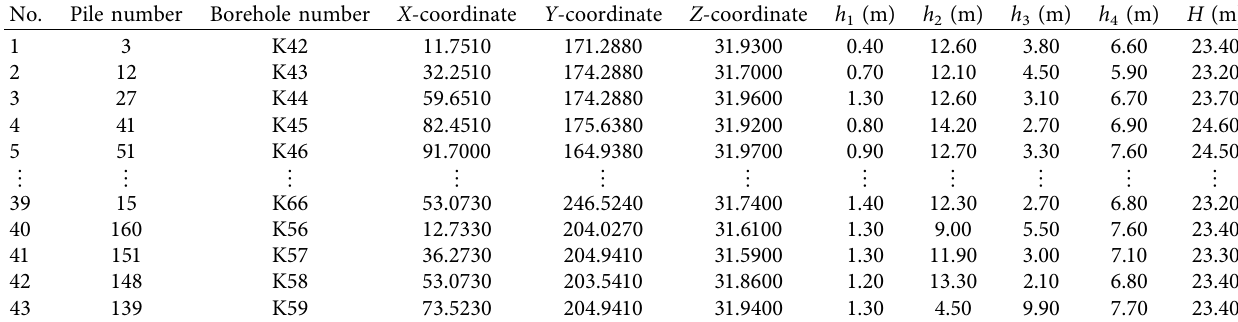
Table 1: 43 groups of data for training.